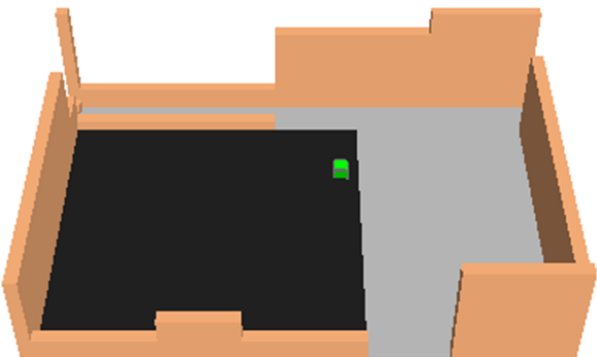
Figure 11. Current layout (S1).